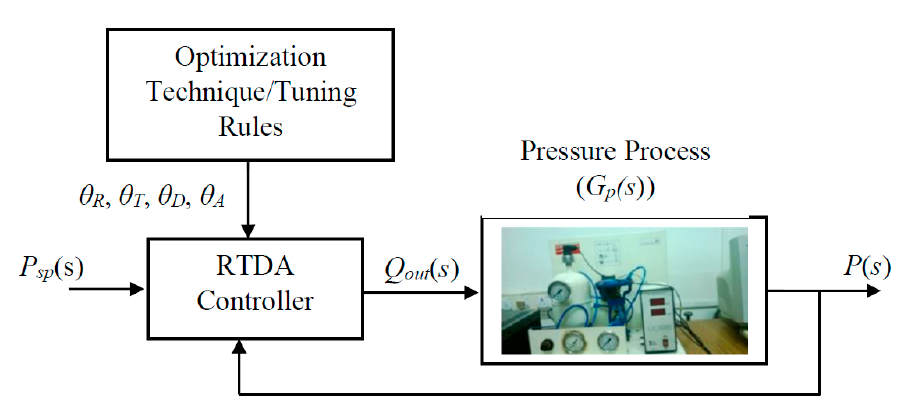
Figure 20. Pressure control station [38].